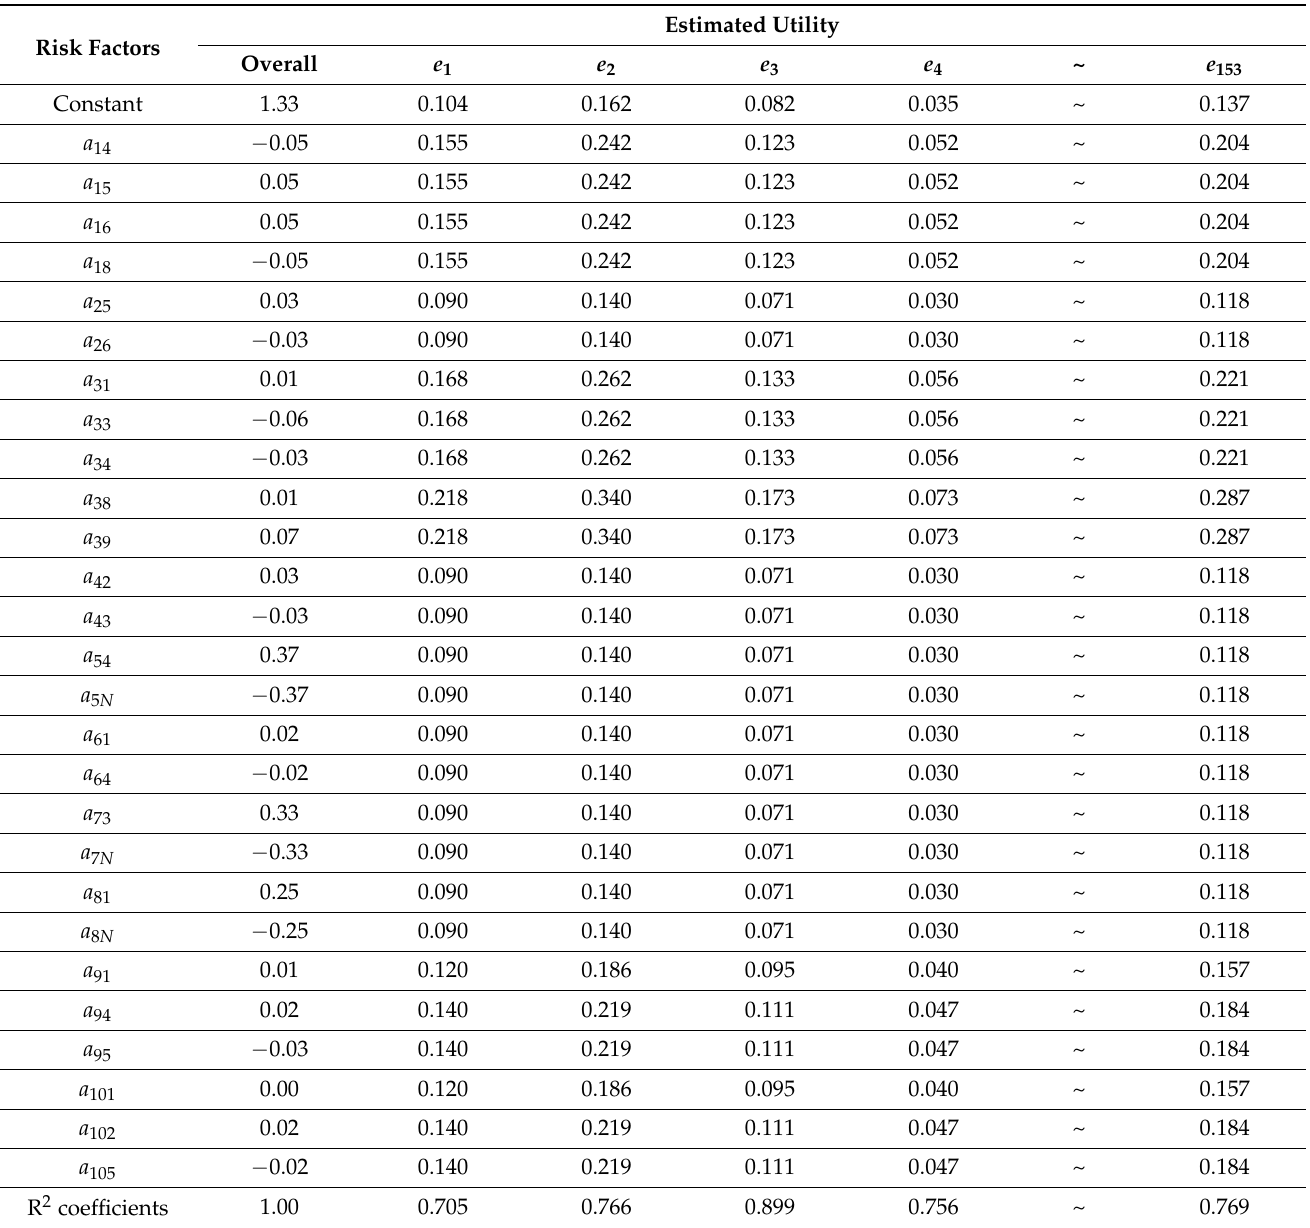
Table 7. Estimated utility of PSCRD